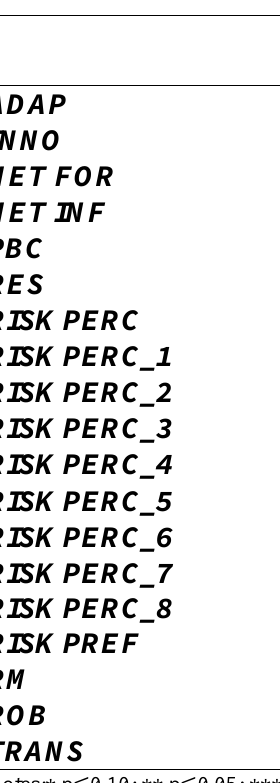
Table A1.8. Compositional invariance assessment